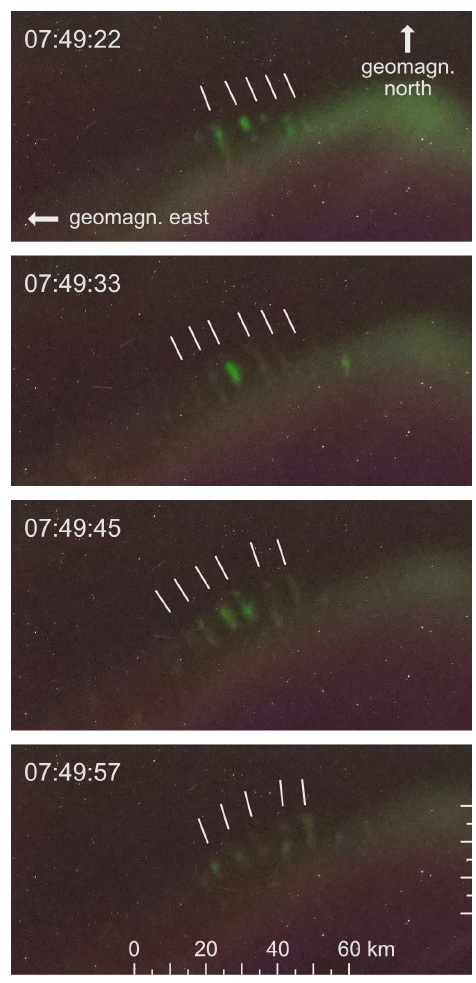
Figure 3. Movement of a category 2 FAE group northwards of the main auroral arc (northwest of zenith) over four successive images taken on 18 December 2017 around 07:49:40UTC. The images are cropped to 1000 × 500 pixels to make the FAEs easily identifiable. White lines indicate the apparent alignment of the FAEs and were used to determine approximate distances between them. A scale (in kilometres) is added for reference, using a pixel to kilometre ratio of 0.129 (at 65 ◦ elevation angle). Credit: ASC images provided by the